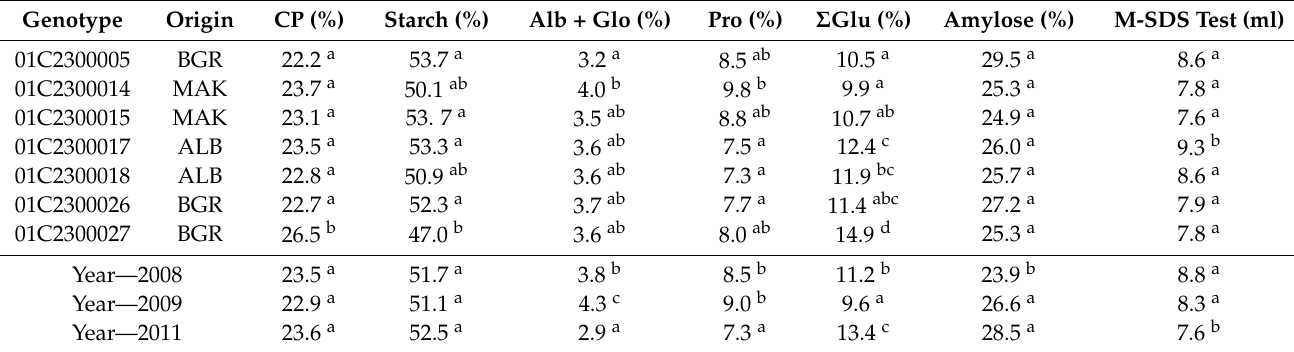
Table 4. Comparison of seed compositions among individual populations of Dasypyrum villosum in tested years: 2008, 2009 and 2011.